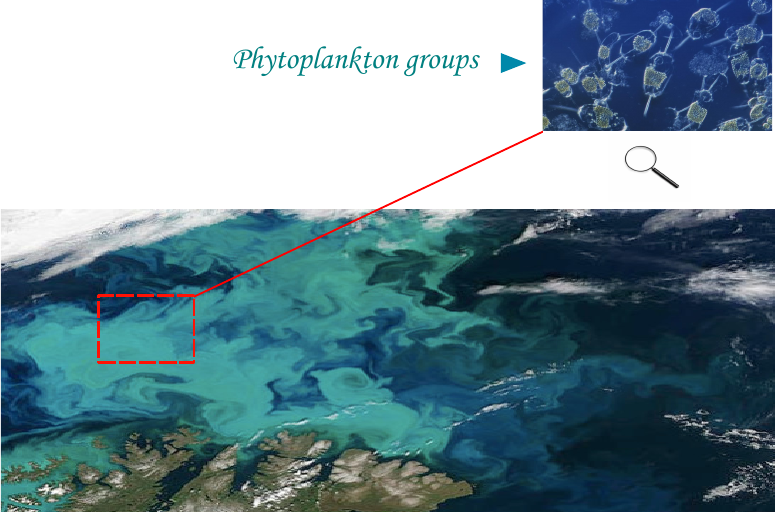
Figure 1. Satellite image of phytoplankton assemblages taken by NASA (mediterranean ocean). This illustrates that phytoplankton dwell the upstairs sunlit coat of the ocean, called the euphotic area. Zooplankton is a taxonomically diverse group of organisms at different levels of the marine food chain. Protozooplancton brings together the unicellular organisms of zooplank- ton and is mainly composed of heterotrophic flagellates, ciliates and certain heterotrophic dinoflagellates which feed mainly on pico and nano-phytoplankton as well as bacteria. Actu- ally, zooplankton have a key position in the marine food web by carrying out secondary production. By grazing on phytoplankton and then being consumed by higher trophic levels, it helps connect primary producers with the rest of the food web